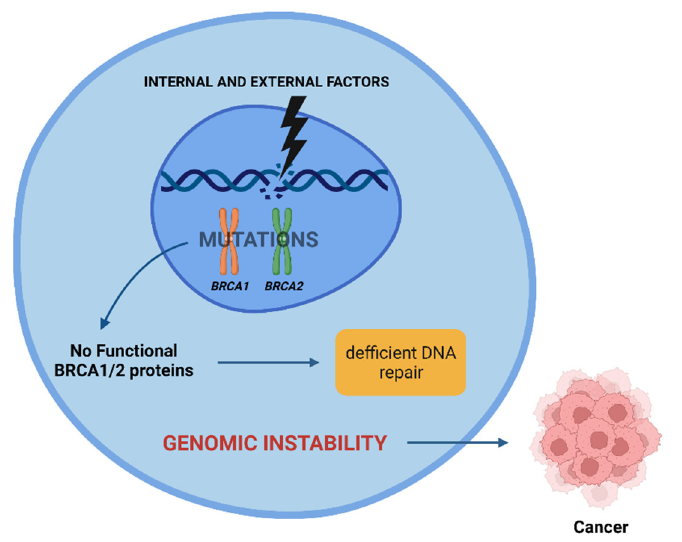
Figure 3. Effect of internal and external factors on BRCA1 and BRCA2 genes. Mutations in these genes lead to inefficient DNA repair, contributing to genomic instability. This instability can lead to cancer. Created with BioRender.com.